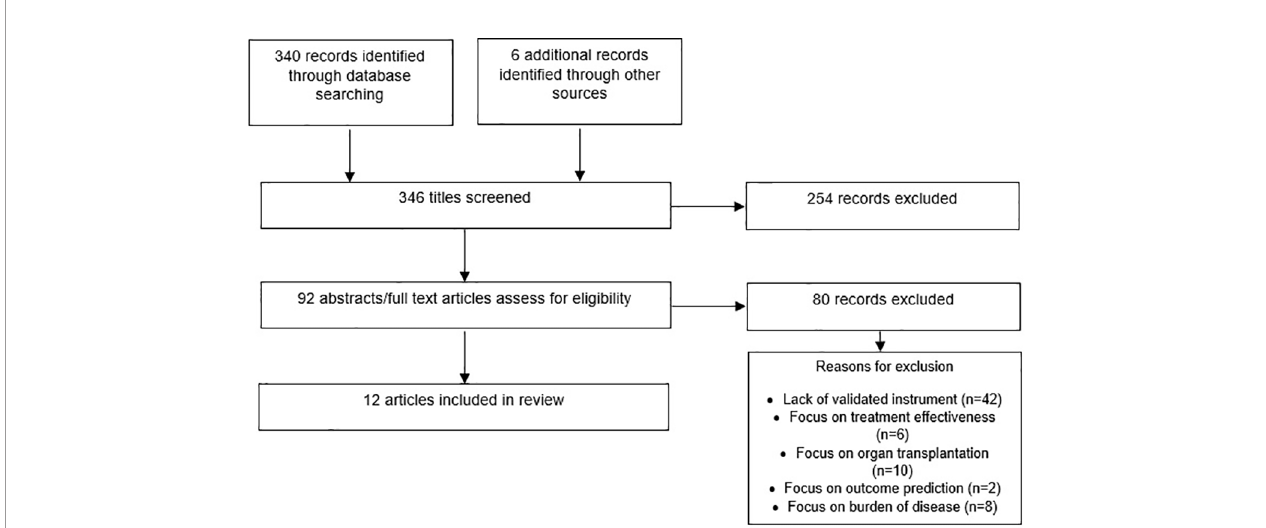
FIGURE 1 | Flow of information in this review.